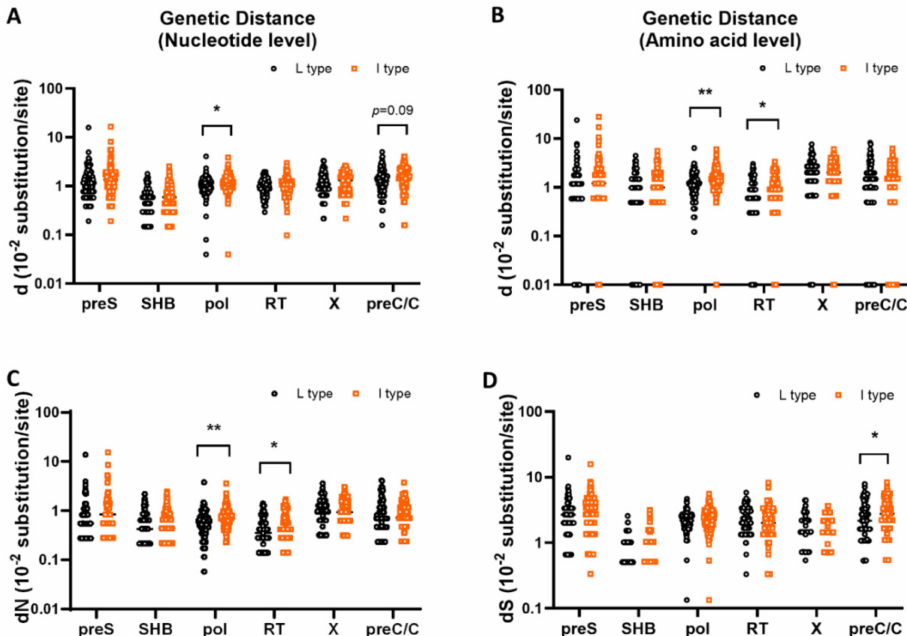
Figure 3. Comparison of genetic diversity in the PreS, S, X, PreC/C and Pol regions between rt269L and rt269I. Comparison of genetic distance at the nucleotide and amino acid levels ( A , B ), dN (the number of nonsynonymous substitutions per nonsynonymous site) ( C ), and dS (the number of synonymous substitutions per synonymous site) ( D ) within the PreS, S, X, PreC/C and Pol regions between rt269L and rt269I. Significant differences (* p < 0.05, ** p < 0.01) analyzed by independent samples t -test between the groups are shown in the related